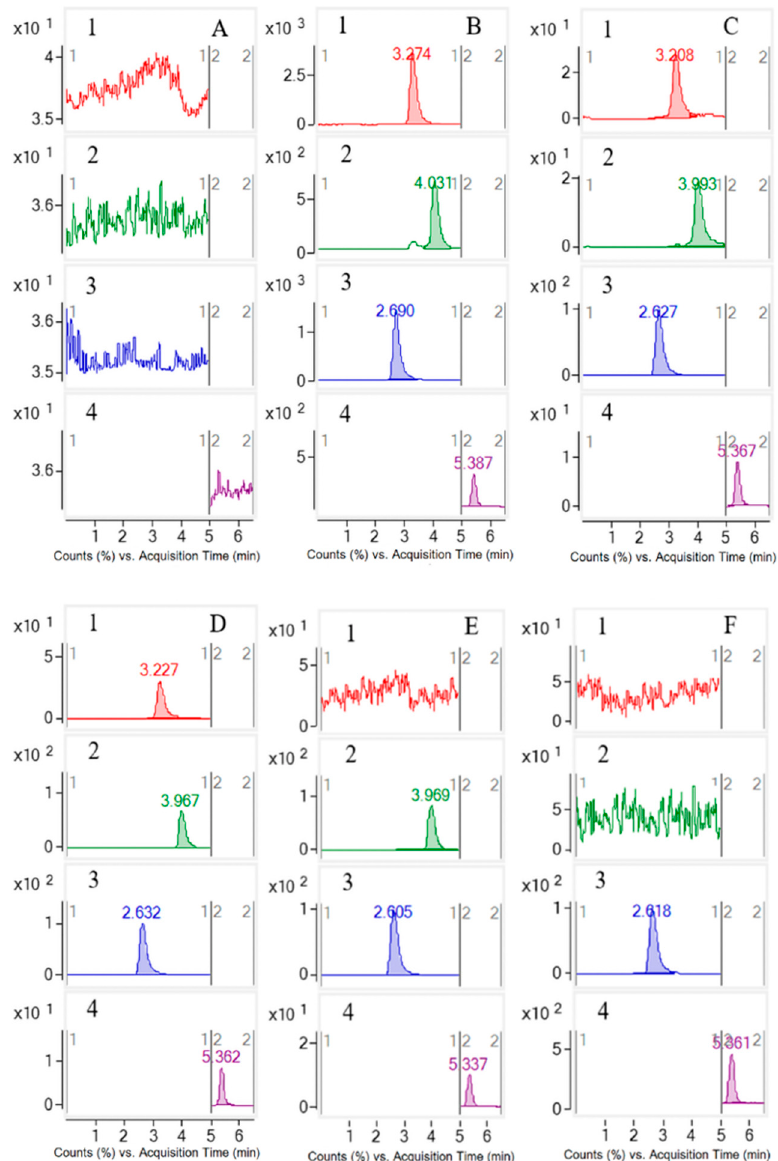
Figure 1. The chromatograms of ZGI ( 1 ), DGE ( 2 ), PA ( 3 ), and IS ( 4 ) in rat plasma samples. ( A ) Blank plasma; ( B ) plasma samples after oral administration of S. officinalis extract 1.5 h; ( C ) LLOQ sample (three analytes and IS in blank plasma); ( D ) plasma samples after oral administration of ZGI 1.5 h; ( E ) plasma samples after oral administration of DGE 1.0 h; ( F ) plasma samples after oral administra- tion of PA 1.0 h.